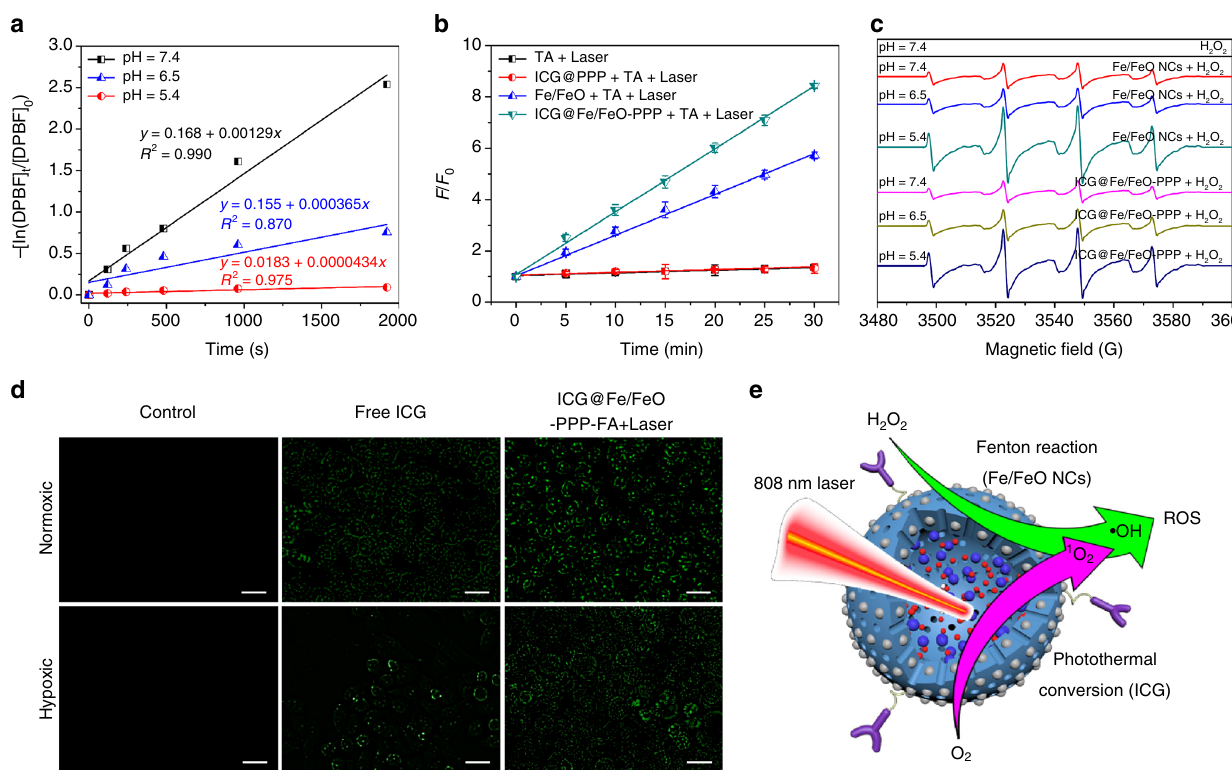
Fig. 3 Evaluation of the ROS generation and the mechanism of ROS production. a Detection of 1 O 2 by UV-vis absorbance spectra for ICG@Fe/FeO – PPP nanocapsules with DPBF at pH value of 7.4, 6.5 and 5.4 phosphate buffer. b Fluorescence intensity of TAOH at 440 nm as a function of laser irradiation time for the ICG@Fe/FeO – PPP nanocapsules and different control treatments. F 0 and F were the fl uorescence intensities of the system without or with treatment, respectively. The error bars represent the standard deviations of three separate measurements. c ESR spectra of Fe/FeO NCs and ICG@Fe/ FeO – PPP nanocapsules with DMPO as the spin trap in different pH values condition (7.4, 6.5 and 5.4). d 1 O 2 generation evaluated by DHR123 in KB cells treated with free ICG and ICG@Fe/FeO – PPP – FA nanocapsules under normoxic and hypoxic conditions (scale bars: 20 μ m). e Synergism schematic of Fenton reaction of Fe/FeO NCs with photothermal conversion (ICG) in ICG@Fe/FeO – PPP – FA nanocapsules. (Error bars, mean ± SD, n = 6, ROS reactive oxygen